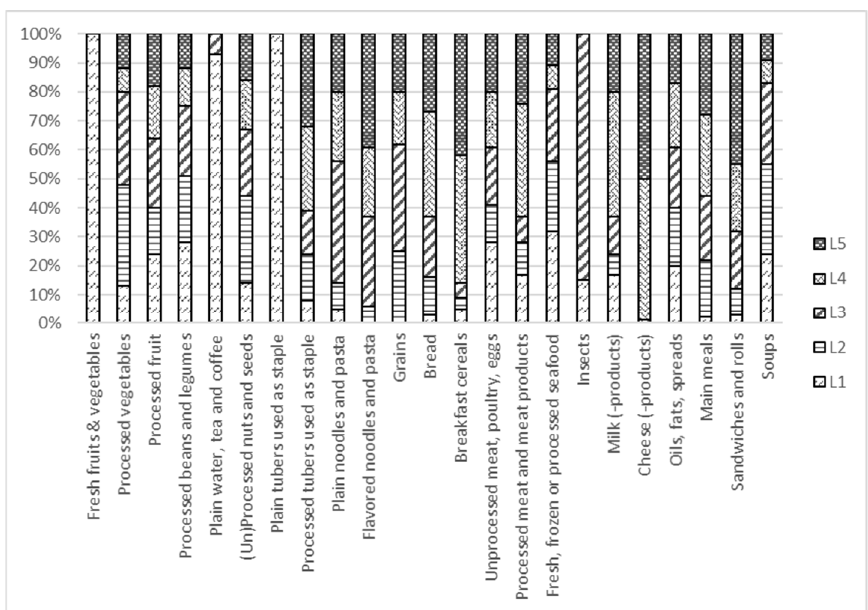
Figure 5. Distribution of products in the database over levels L1–L5 for basic food groups. Due to the use of WHO benchmarks and the validation against indicator foods, a relatively high percentage of fresh and processed fruit and vegetables, legumes, plain water, tea and coffee, and plain tubers are classified as healthier, whereas other food groups, such as flavored noodles and pasta, breakfast cereals, bread, and cheese contain more less healthy products.